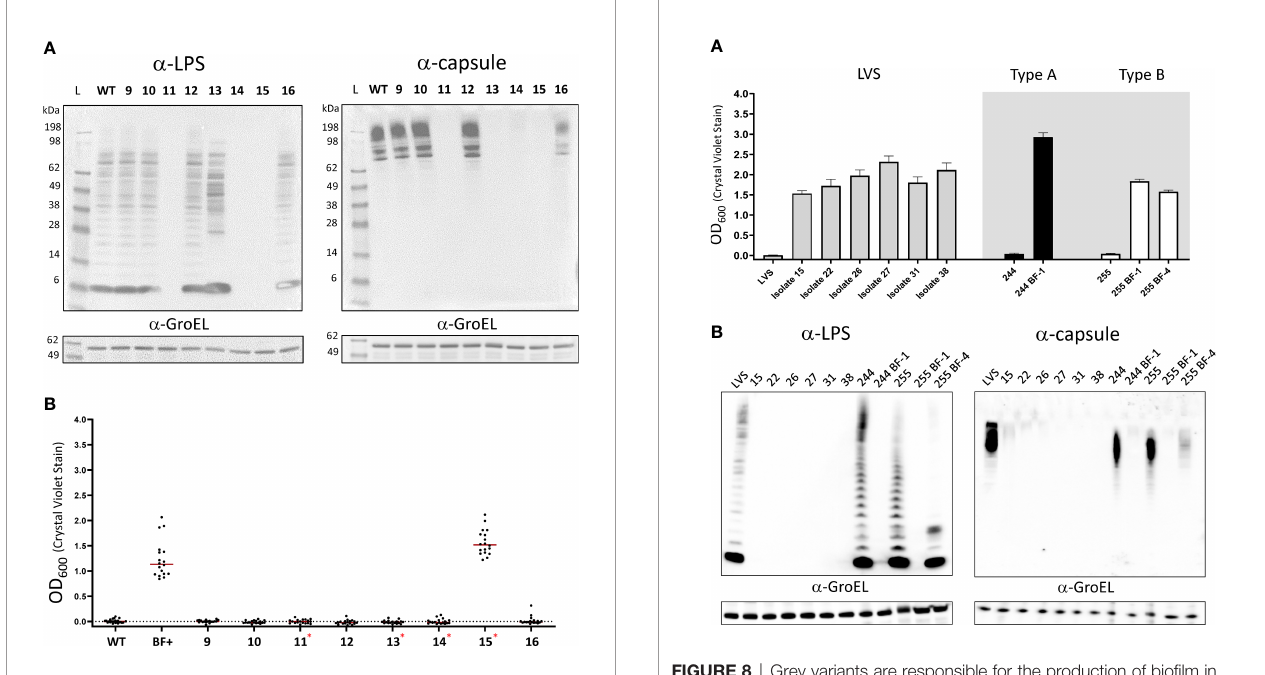
FIGURE 7 | Blue-grey phase variation is readily observed in bio fi lm forming cultures. (A) Western blot analysis of LVS strains was performed on 8 representative colony variants that arose after streaking bio fi lm positive freezer stocks on chocolate agar. Pellets from puri fi ed isolates were lysed and equal concentrations of extracts were separated on SDS-PAGE gels blotted with either a -LPS (left) or a -capsule (right). In each case, a -GroEL was used as a loading control. WT corresponds to the wild-type LVS strain. Numbers correspond to the respective variant isolates. (B) A crystal violet bio fi lm assay was used to determine the bio fi lm forming capacity of each of the puri fi ed LVS isolates. Red asterisks indicate grey variants as identi fi ed by western blotting. Red lines indicate the median.